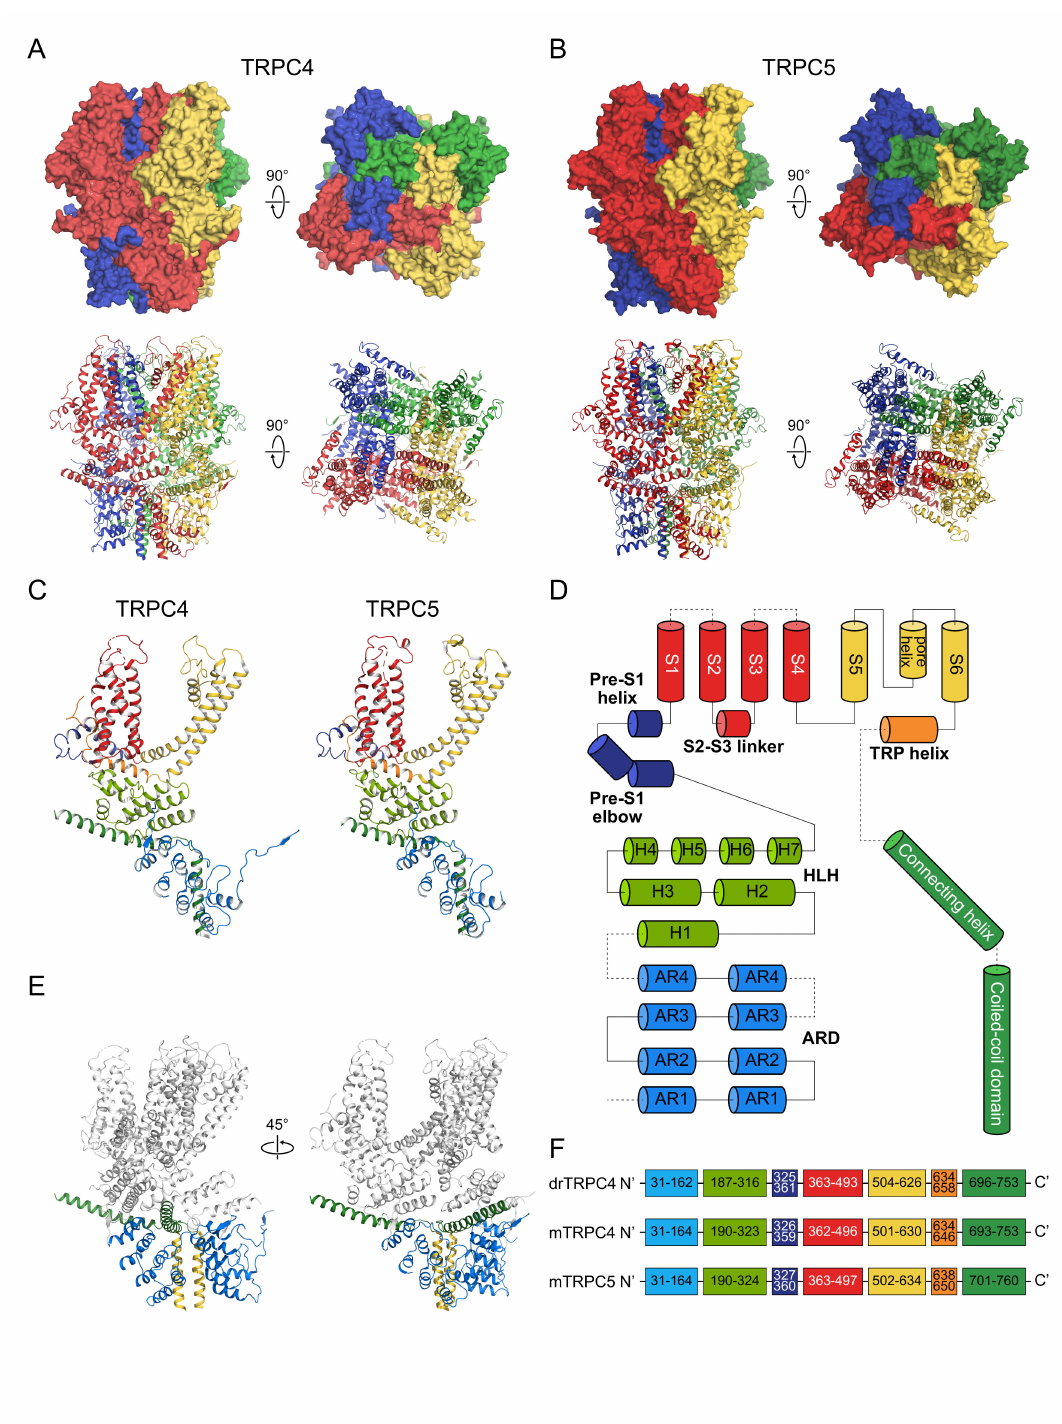
Figure 1. General architecture of the TRPC4 and TRPC5 channels. ( A , B ) Tetrameric structures of the channels. Upper panel: surface map of the channels; Lower panel : cartoon diagram of the channels. ( C ) Monomers of each channel. The colors of each domain correspond to the domain diagram in ( D , F ). ( D ) Domain diagram of TRPC4 and 5 channels. From the N -terminal cytoplasmic domain to the C-terminal cytoplasmic domain, ARD, HLH, Pre-S1 elbow, Pre-S1 helix, VSLD, S5, S5-S6 linker, pore helix, S6, TRP helix, connecting helix, and the coiled-coil domain are shown. ( E ) Relationship between ARD and the connecting helix. Blue domains: ARD; Green domains: connecting-helix; Yellow domains: coiled-coil domains. ( F ) Amino-acid numbers corresponding to each